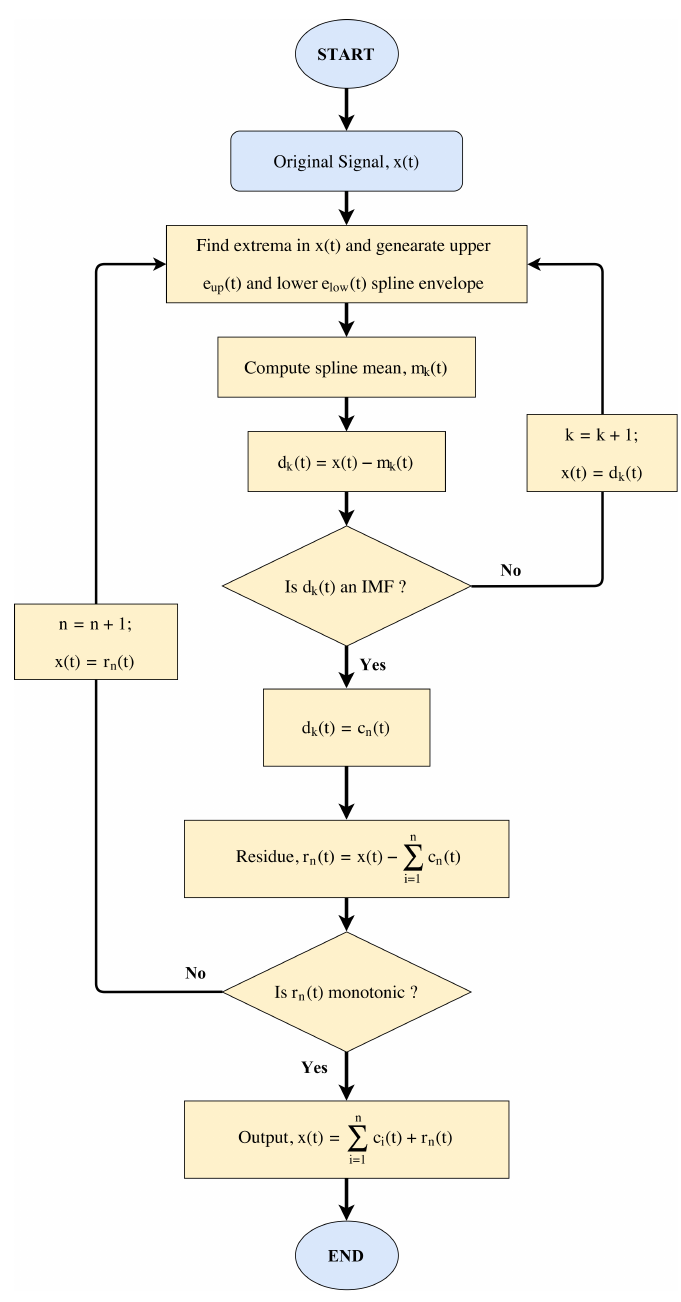
Figure 1. Flowchart of the Empirical Mode Decomposition